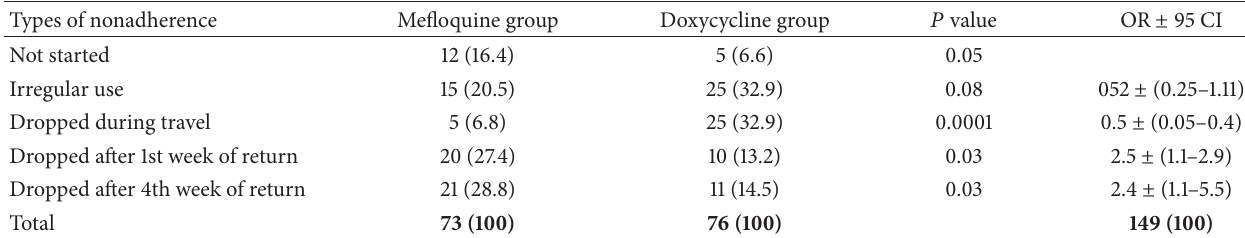
Table 2: Nonadherence types among the studied